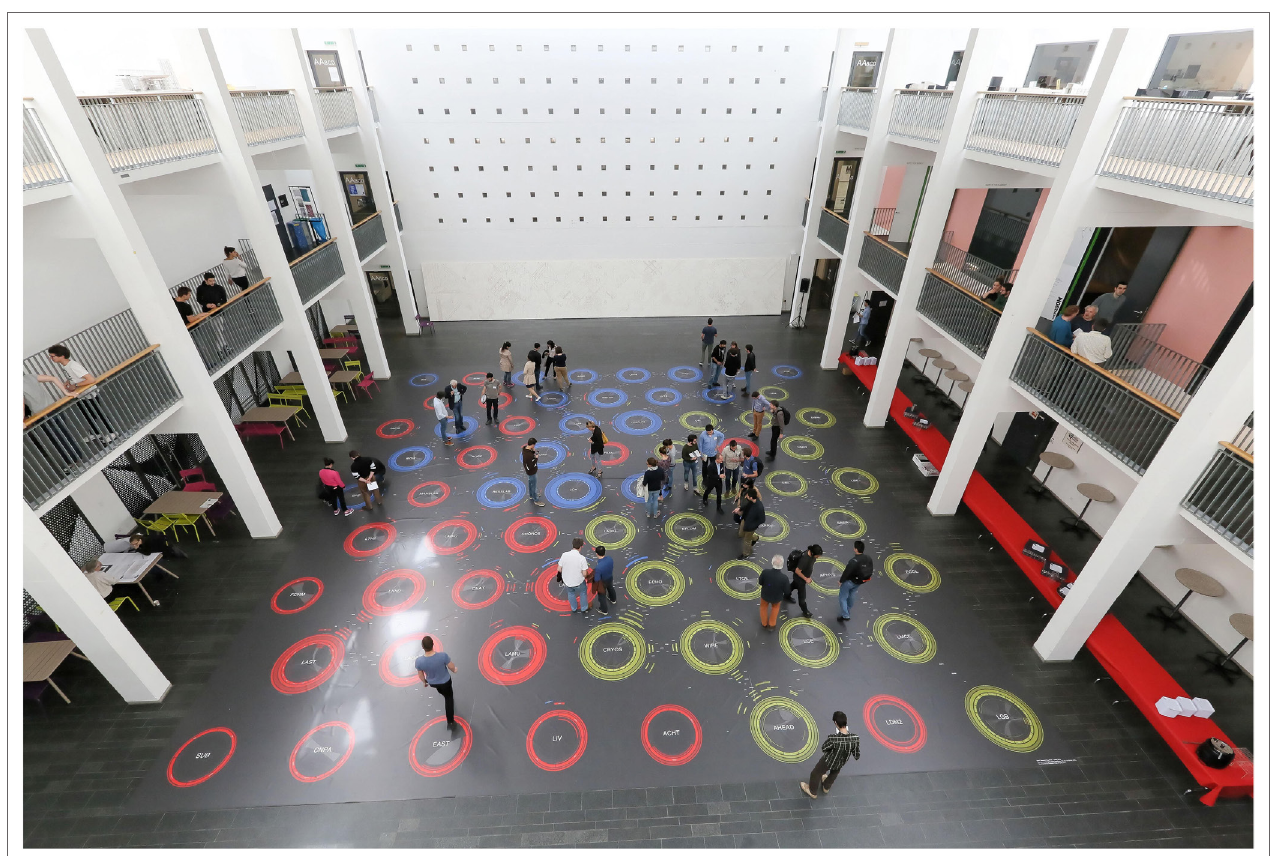
FigUre 8 | The actualization of the Affinity Map as a carpet. That installation that has been created for the School of Architecture, Civil and Environmental Engineering Research Day covers a surface of 250m 2 . Members of the school were invited to walk on to find themselves and their peers (reproduced with the permission of the copyright holder Alain Herzog,